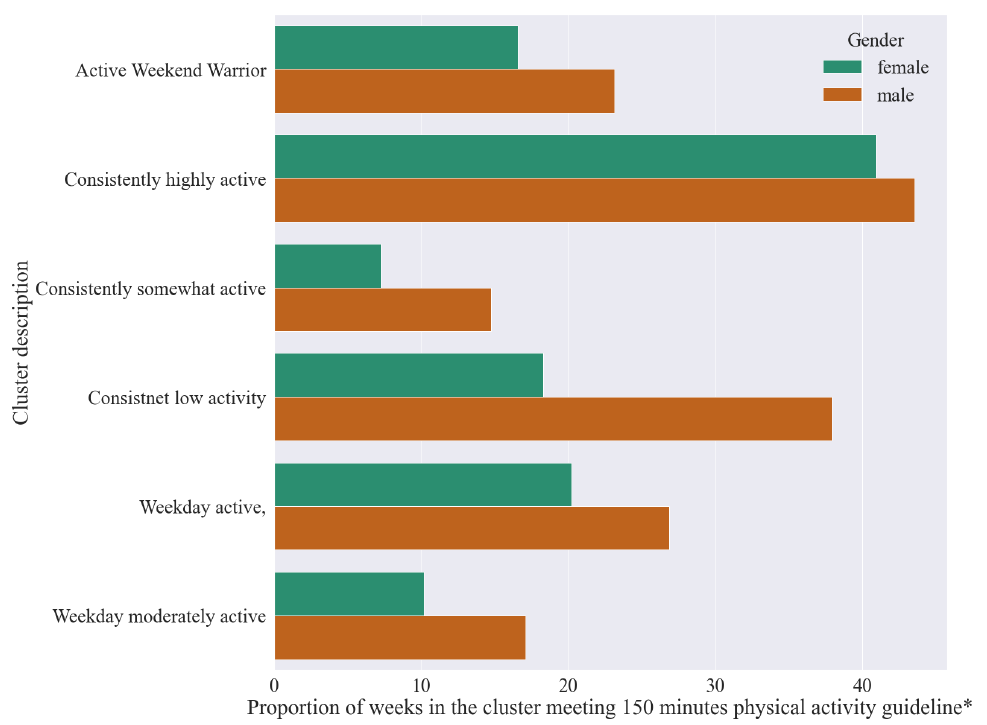
Figure 11. Proportion of weeks in the weekly step behaviour clusters meeting the WHO 150 min(*) of MVPA guideline, by